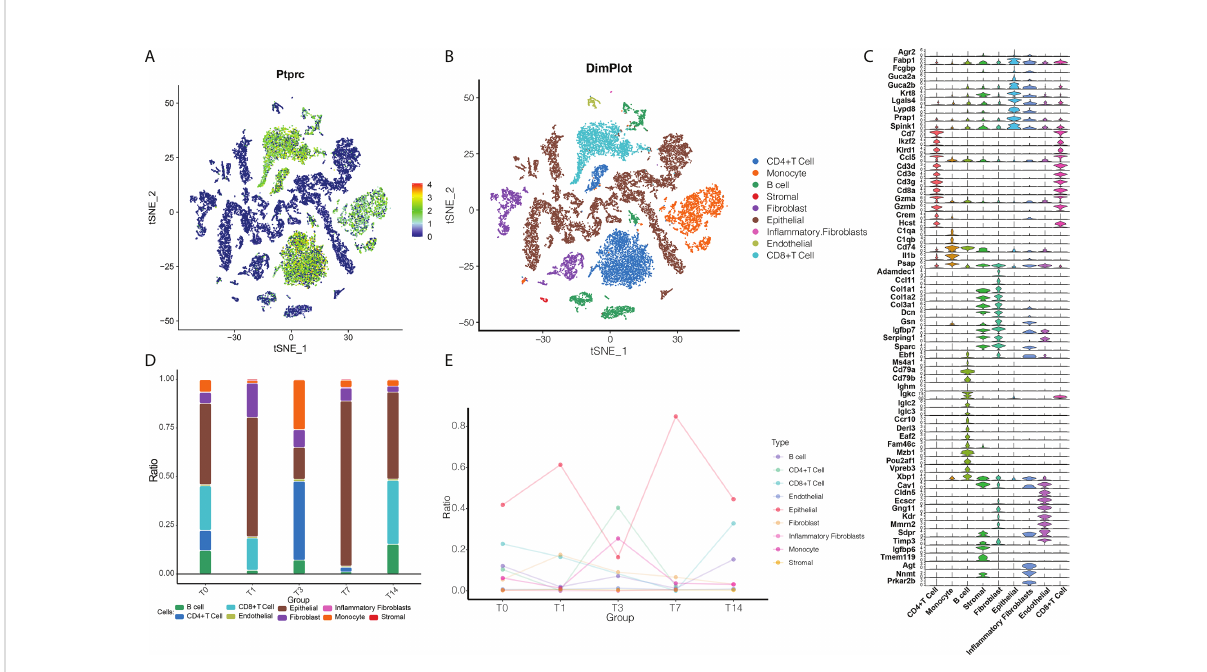
FIGURE 1 RT reprograms intestinal tissues at the cellular level. (A) The single-cell map based on CD45. Blue indicates that the cells were negative for CD45; green, that the cells were positive for CD45. (B) Cell ecosystem after radiation exposure. Different colors represent different cell types. (C) Expression of marker genes in different cells undergoing radiotherapy reprogramming. (D) Cell ecosystem after radiation exposure. The colors of the columns represent different cell types. (E) Changes in the ecosystem over time after radiation